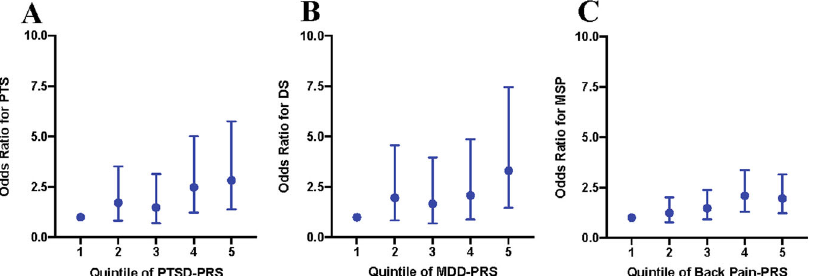
Fig. 2 Odds ratios for each quintile of the polygenic risk scores for PTS, DS, and MSP as derived using the respective PTSD, depression, and back-pain GWAS summary statistics. The fi rst quintile is used as a reference. For every other quintile, the odds ratio relative to the fi rst quintile is displayed for A posttraumatic stress (PTS), B depressive symptoms (DS), and C musculoskeletal pain (MSP). For PTS, individuals in the fi fth quintile have 2.8 times higher odds of developing PTS than individuals in the fi rst quintile. The error bars indicate 95% con fi dence intervals around the odds